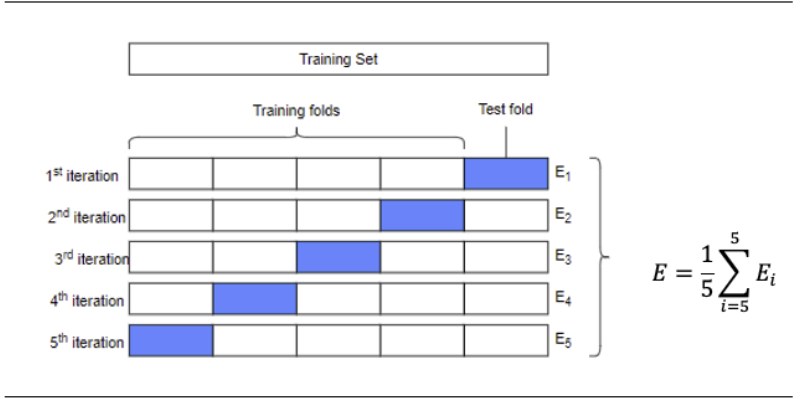
Figure 3. Train Test Split